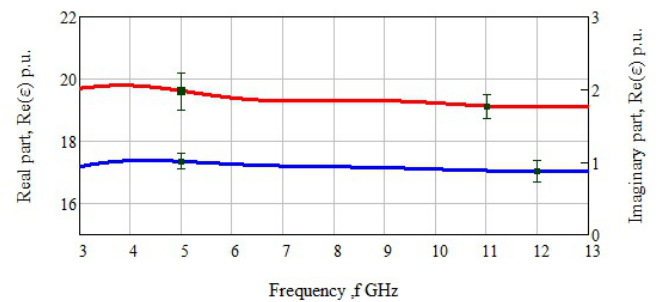
Figure 15. The values of the real and imaginary parts of the dielectric permittivity dependence frequency for a non-plane